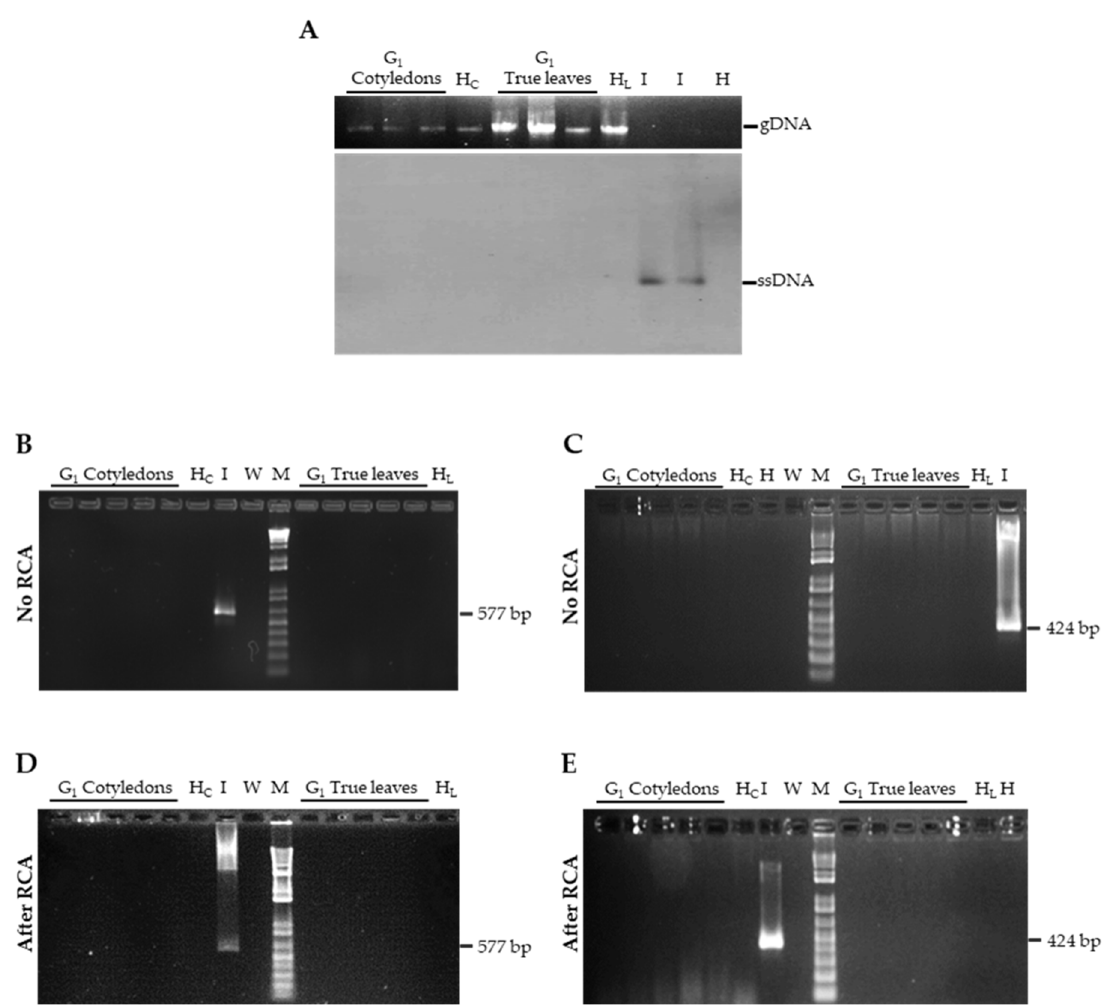
Figure 2. Detection of TYLCSV DNA in G 1 seedlings. ( A ) Southern blot analysis on cotyledon and true leaf extracts from TYLCSV-infected plants. H C and H L extracts from cotyledon or true leaves of the G 1 seedlings of healthy plants, respectively. I, DNA extract (3–5 ng) from an infected plant, used as positive control. gDNA, host genomic DNA, shown as loading control. ssDNA, circular single stranded genomic DNA; ( B , C ) PCR analysis of cotyledon and true leaf extracts from TYLCSV-infected plants, performed using the TY1(+)/TY2(-) ( B ) or the TY2458(+)/TY109(-) ( C ) primer pairs. ( D , E ) PCR analysis of RCA products obtained from the same cotyledon and true leaf extracts of B and C, performed with the TY1(+)/TY2(-) ( D ) or the TY2458(+)/TY109(-) ( E ) primer pairs. H C and H L , negative controls as above; H, healthy plant, negative control; I, infected plant, positive control; W, water control; M, 1kb Plus DNA Ladder (Invitrogen, Thermo Fisher Scientific, Waltham, MA, USA).